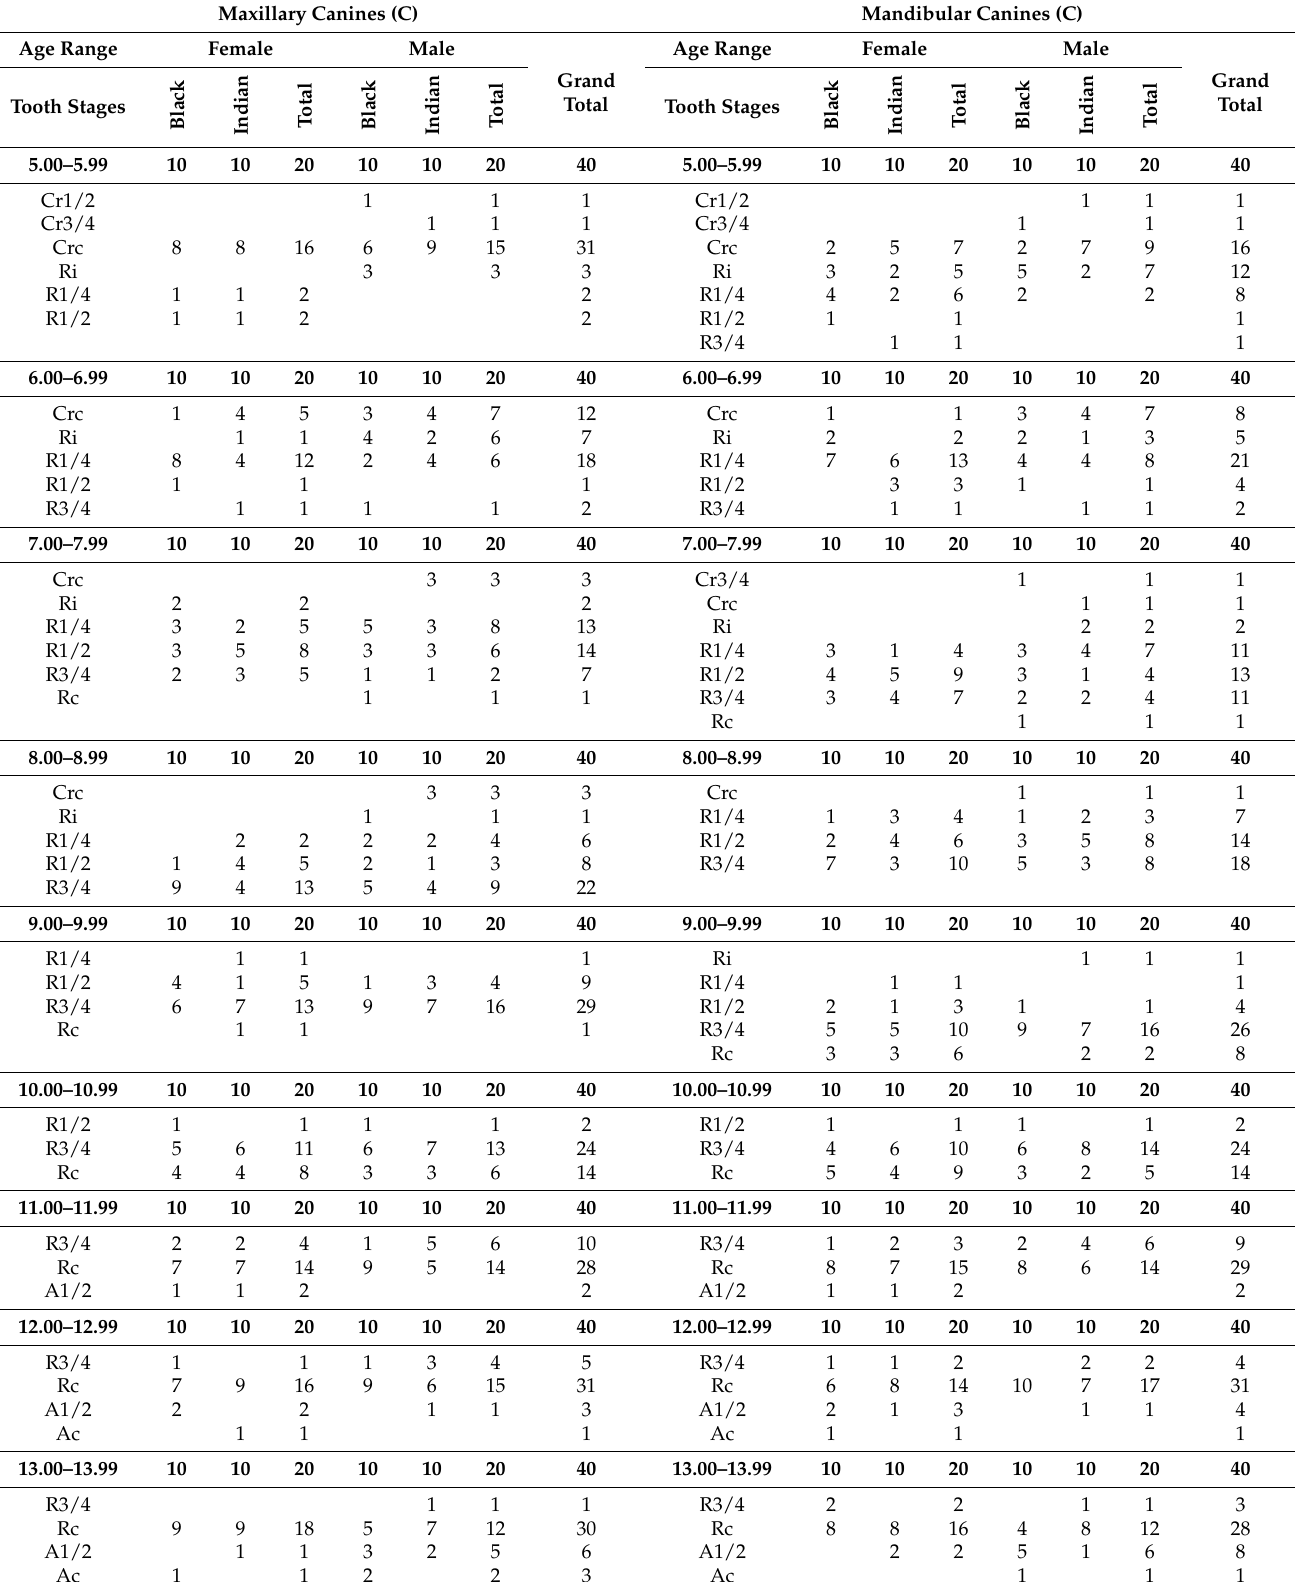
Table A3. Frequencies of the tooth development stages of the canines for the SA Black and Indian population